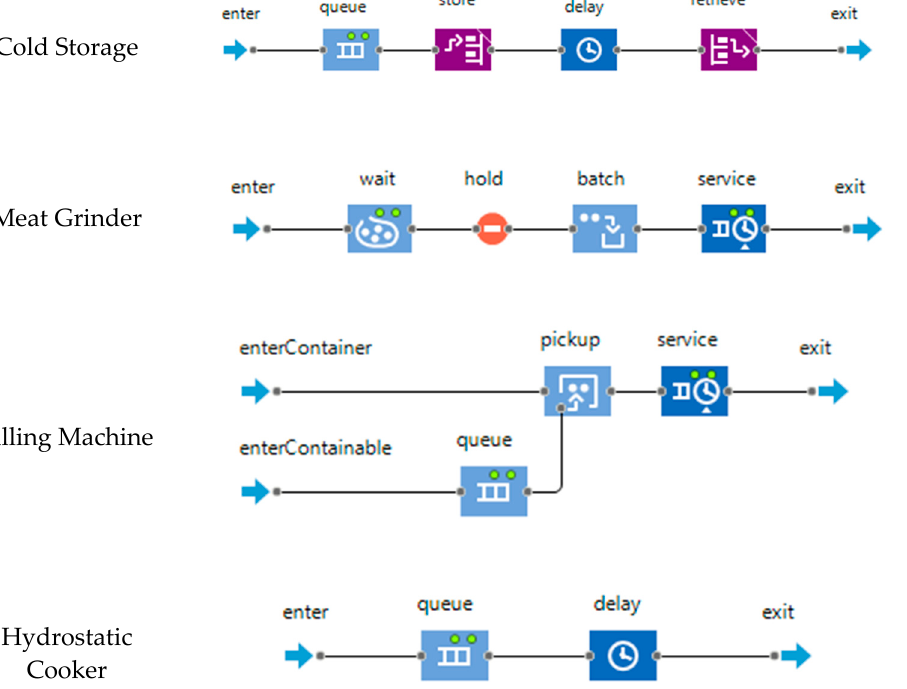
Figure 4. Process-flow agents.